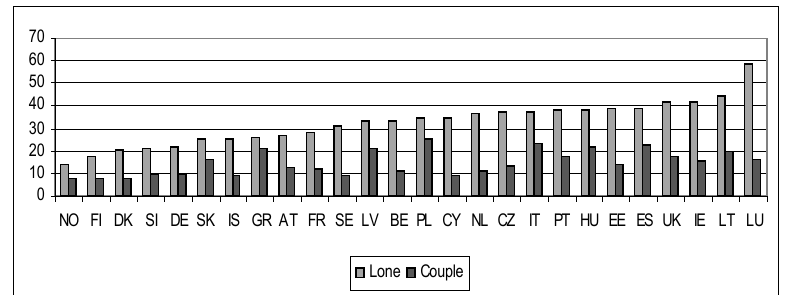
Figure 7 : Child poverty rates for lone parents and